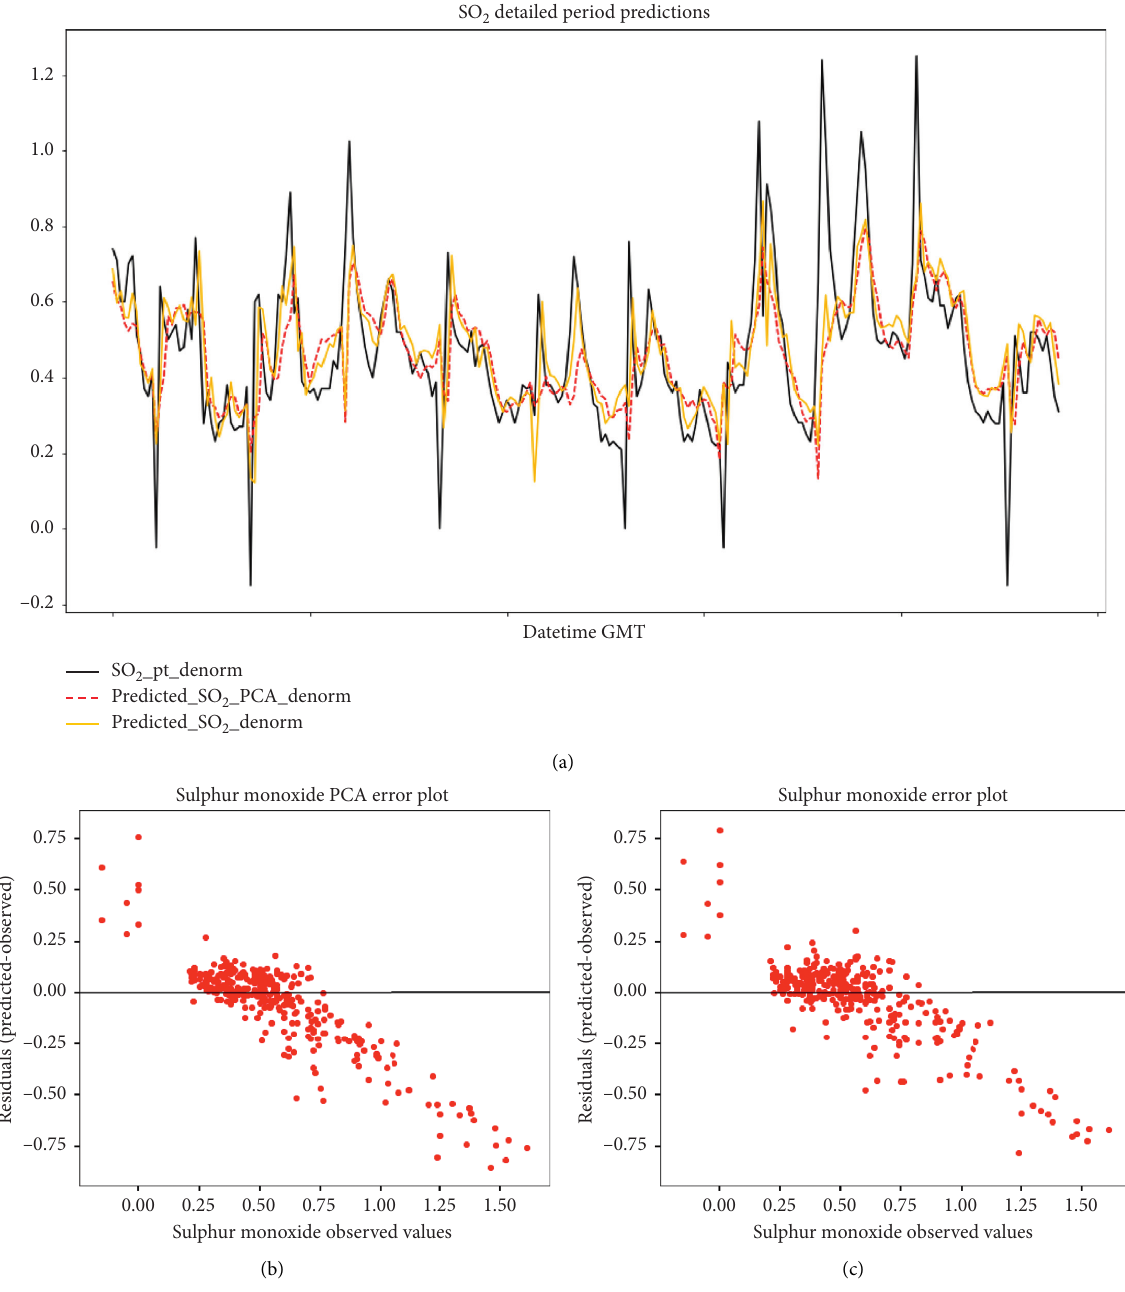
Figure 11: (a) Sulfur dioxide forecasts in California using the produced SVR forecasting models as well as the observed SO 2 values. The black line shows the observed values and the red line shows the produced forecasts with the PCA model, whereas the yellow line shows the forecast produced with the normalized dataset. (b, c) Two scatter plots with model’s respective errors plotted against observed SO 2 values for the same period. Table 7: Error metrics from SO 2 forecasting models in the training and validation